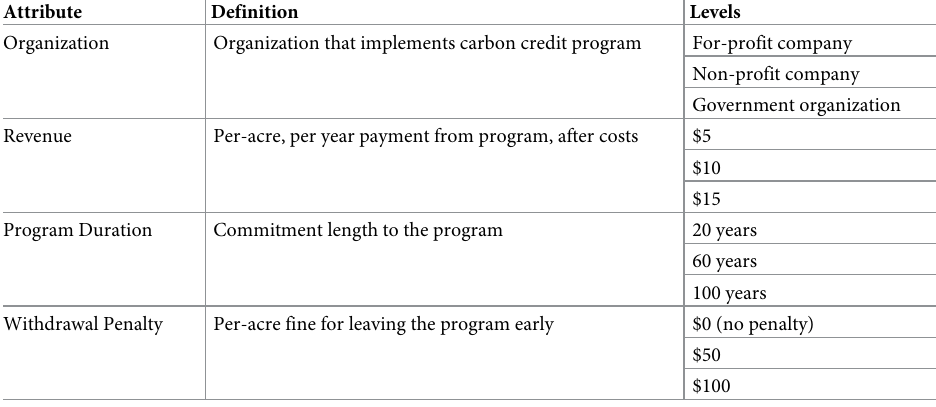
Table 1. Attributes and levels used to create hypothetical carbon credit